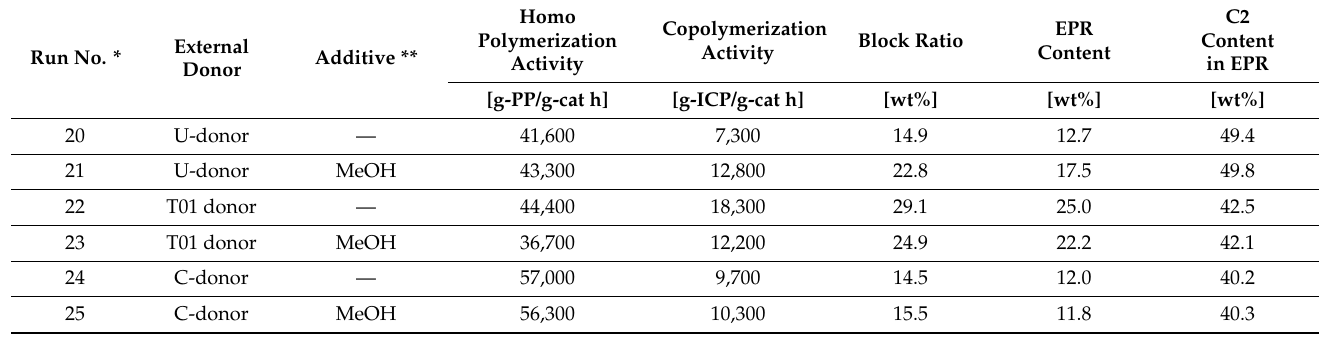
Table 5. Additive effect in impact copolymer production with ZN catalyst combined with